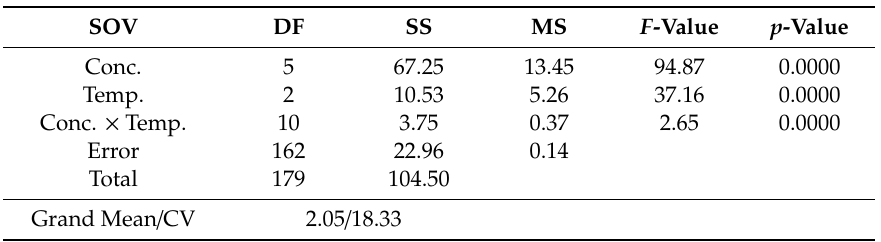
Table A8. Nymphal development time of 3rd instar ( M. persicae ) in relation to PeBL1 elicitor and temperature. SOV DF SS MS Conc. Temp. Conc. × Temp. Total 179